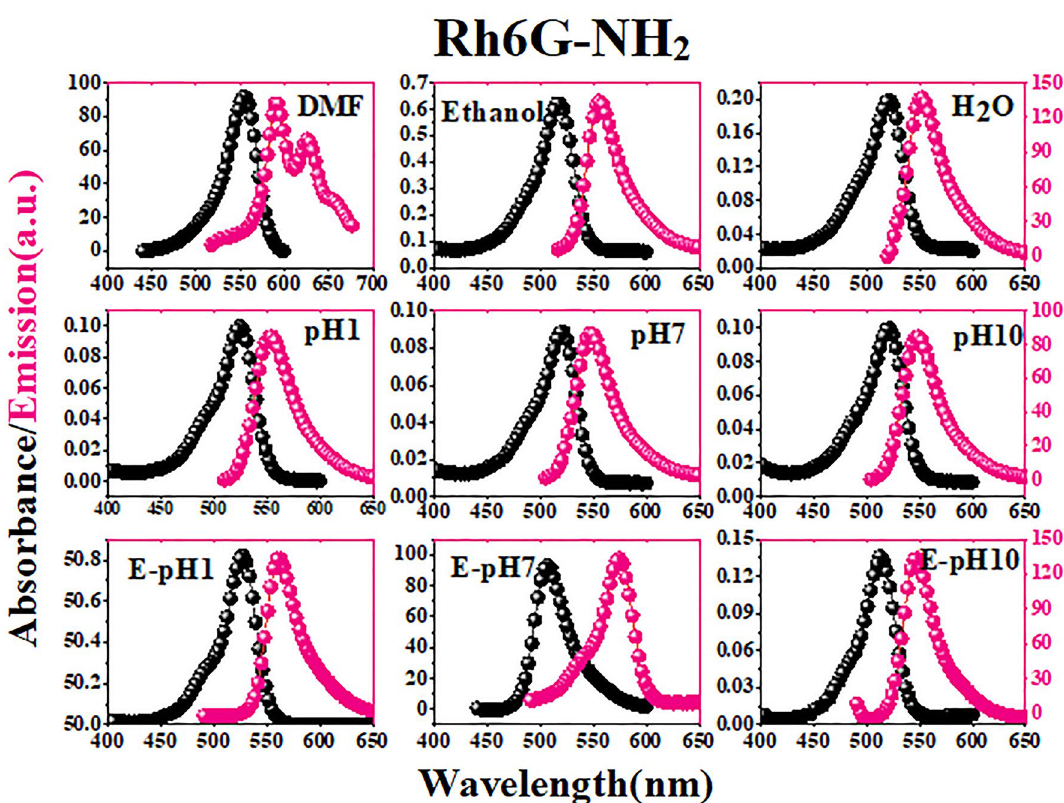
Figure 5. Normalized absorption and fluorescence spectra of Rh6G-NH 2 in different